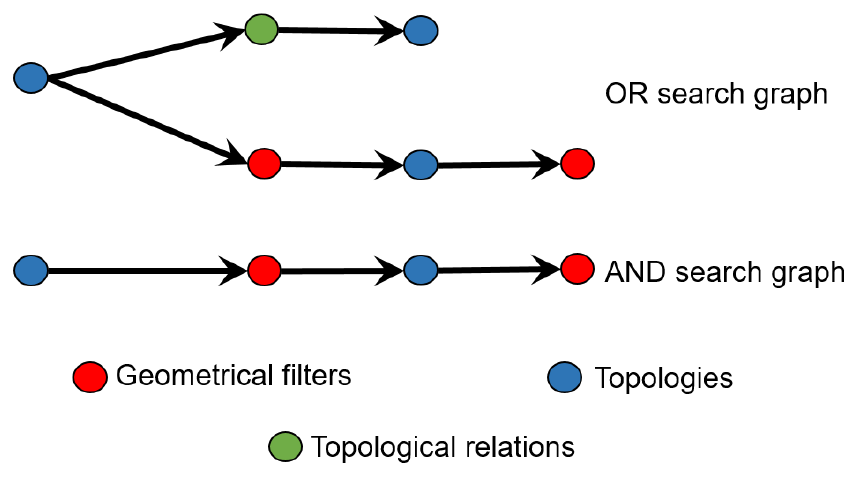
Figure 6. Examples of search graph